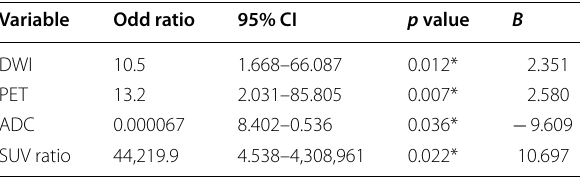
Table 4 Logistic regression for each variable for predicting post‑